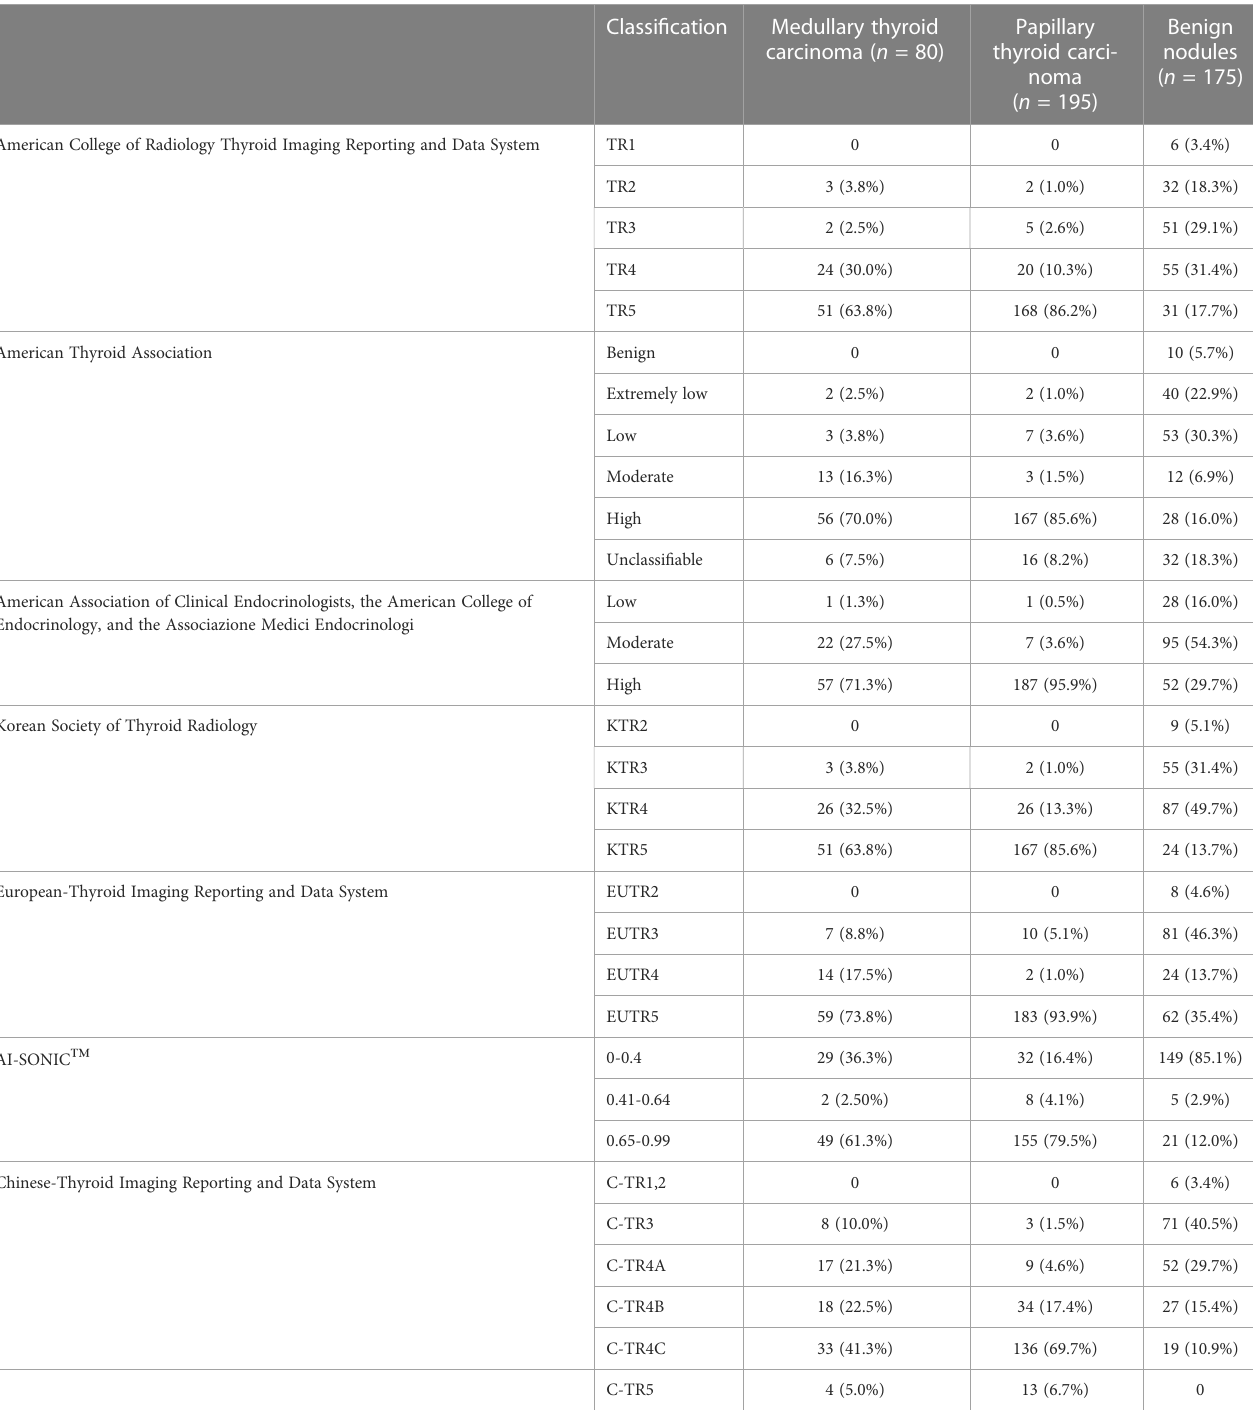
TABLE 2 US classi fi cation of thyroid nodules according to compared